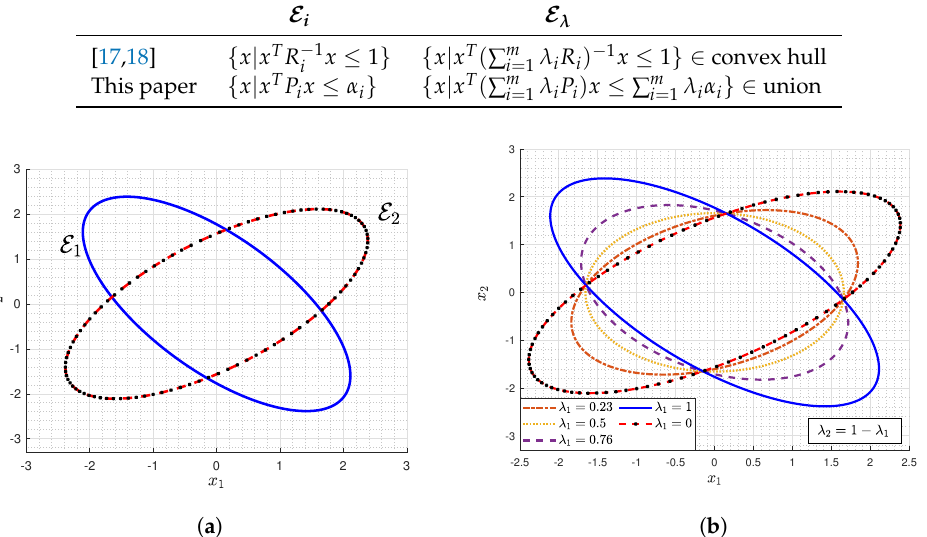
Figure 1. ( a ) For given ellipsoids E 1 and E 2 , ( b ) E λ = { x | x T P λ x ≤ α λ , P λ = ∑ 2